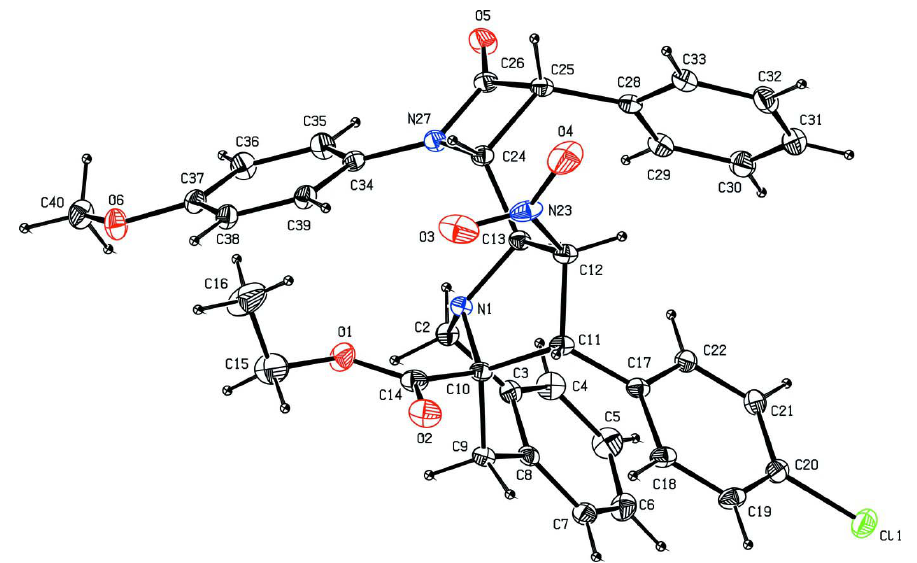
Figure 1 The molecular structure of the title compound, showing 20% probability displacement ellipsoids and the atom-numbering